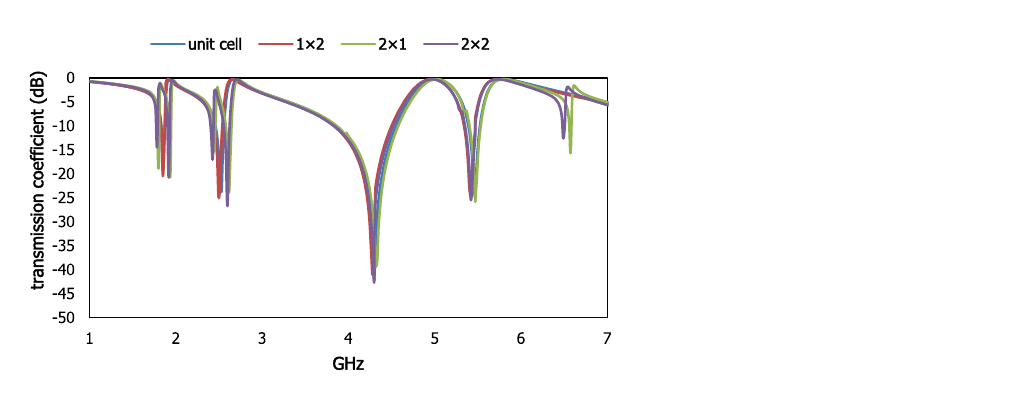
Figure 11. Scattering properties of different array